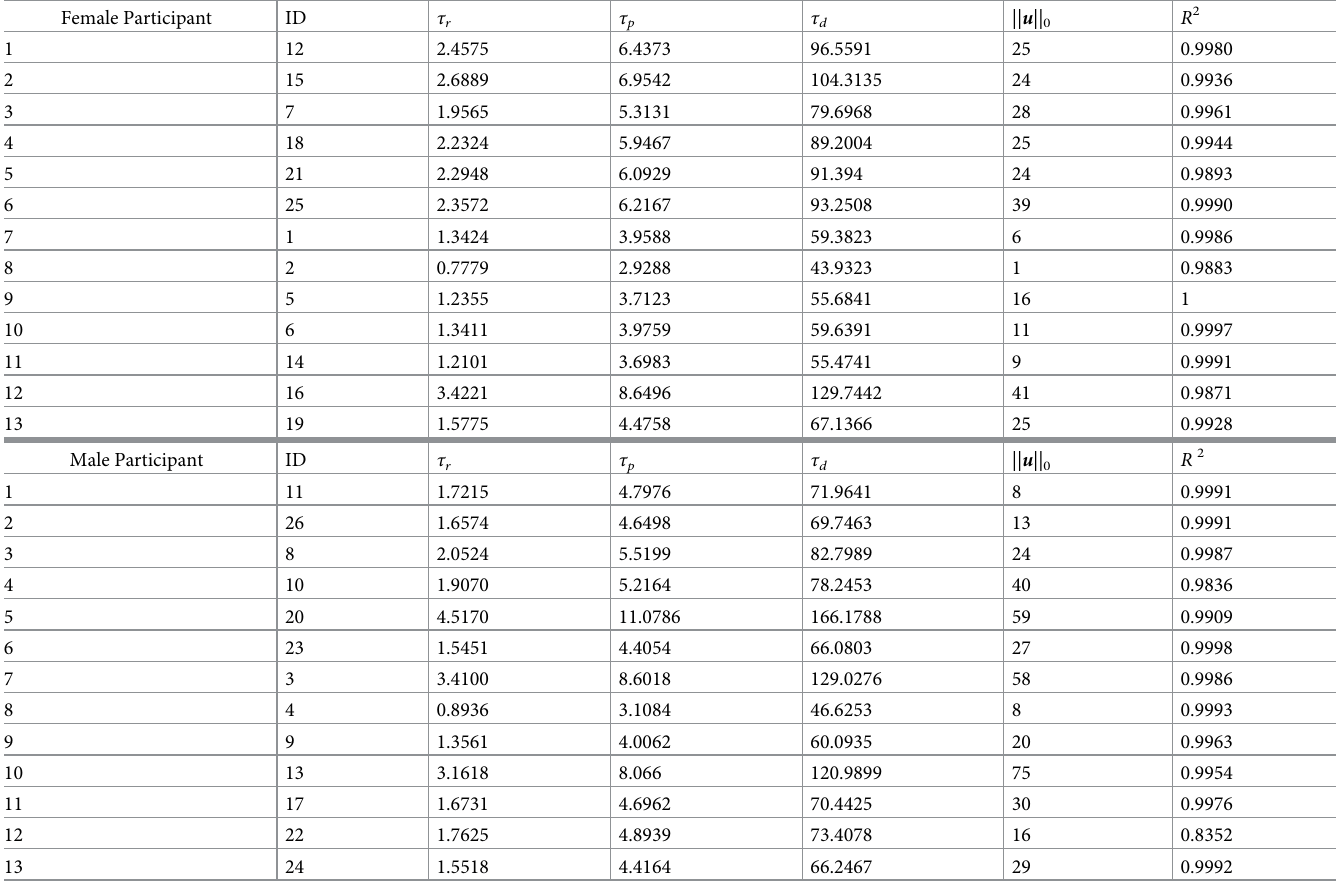
Table 1. The estimated model parameters and the squares of the multiple correlation coefficients ( R 2 ) for the fits of the experimental SC